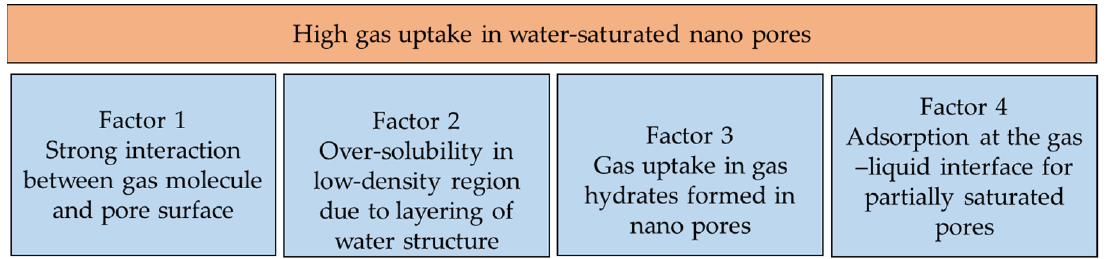
Figure 13. Proposed contribution towards gas over ‐ solubility in water confined in nano pore space.